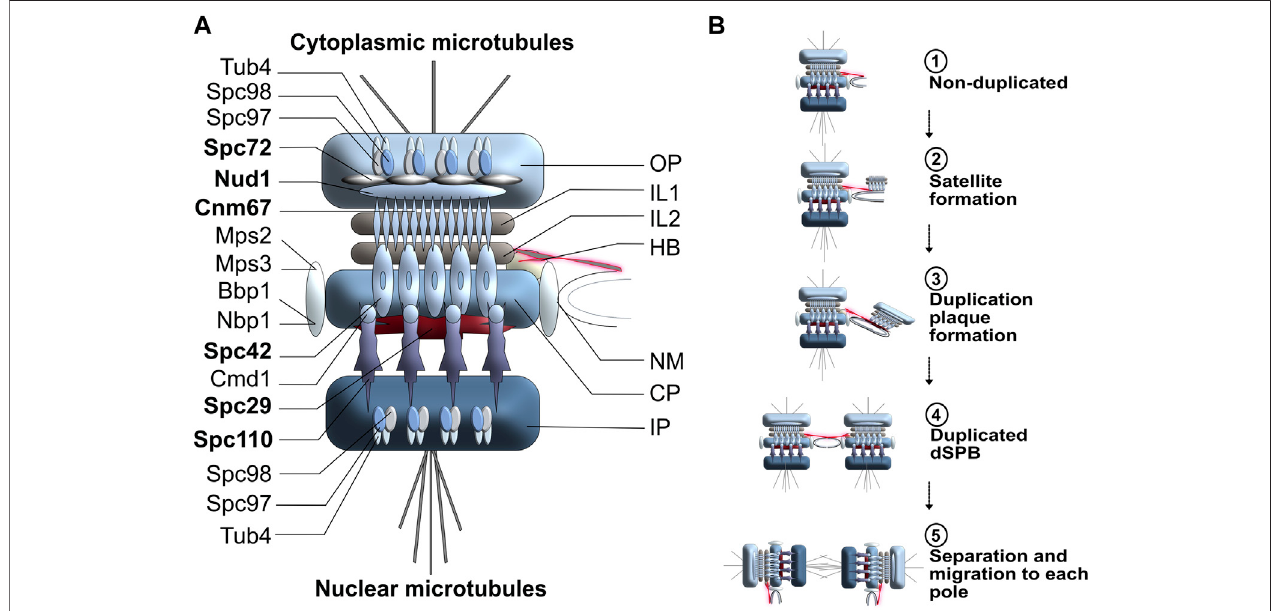
FIGURE 2 | (A) Schematic representation of budding yeast SPB organization and duplication cycle. OP, Outer plaque; IL1, Intermediate layer 1; IL2, Intermediate layer 2; HB, Half-bridge; NM, Nuclear membrane; CP, central plaque; IP; Inner plaque. Core SPB components are highlighted in bold. (B) SPB duplication cycle in buddingyeast.TheduplicationprocessoftheSPBisconservativeandhighlydynamic.Step1:InearlyG1,thehalf-bridgeisconnectedtotheSPBcentralplaqueandwill act asascaffoldforSPBduplication. Step2:Thehalf-bridge elongatesand thecoreofthedaughterSPB(satellite) isgeneratedonthecytoplasmic faceofthehalf- bridge.Step3:Theduplicationplaque,resultingfromtheelongation andgrowth ofthesatelliteSPB,maturesand mimicsthecytoplasmic organizationofamature SPB. Step4:Thehalf-bridgeretractsandfusestothenuclearmembrane.ThedaughterSPBisassembledandisembeddedinthenuclearmembranenexttothemotherSPB. Step 5: The link between mother and daughter SPBs breaks, leading to the separation of the two organelles.